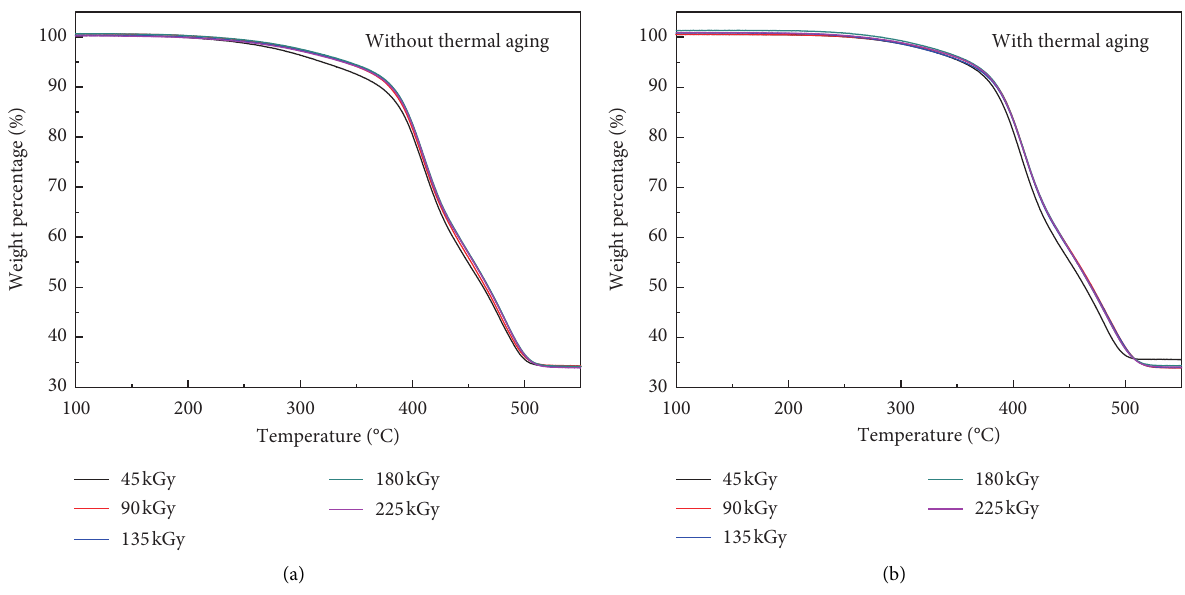
Figure 5: Thermal gravity analysis of BR/NR blends at different doses, non-aging and aging.